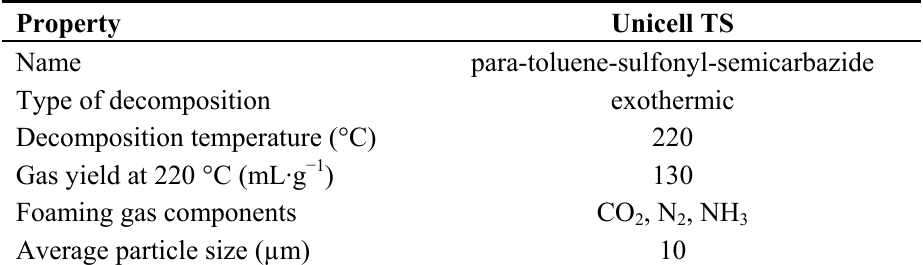
Table 2 . Typical properties of Unicell